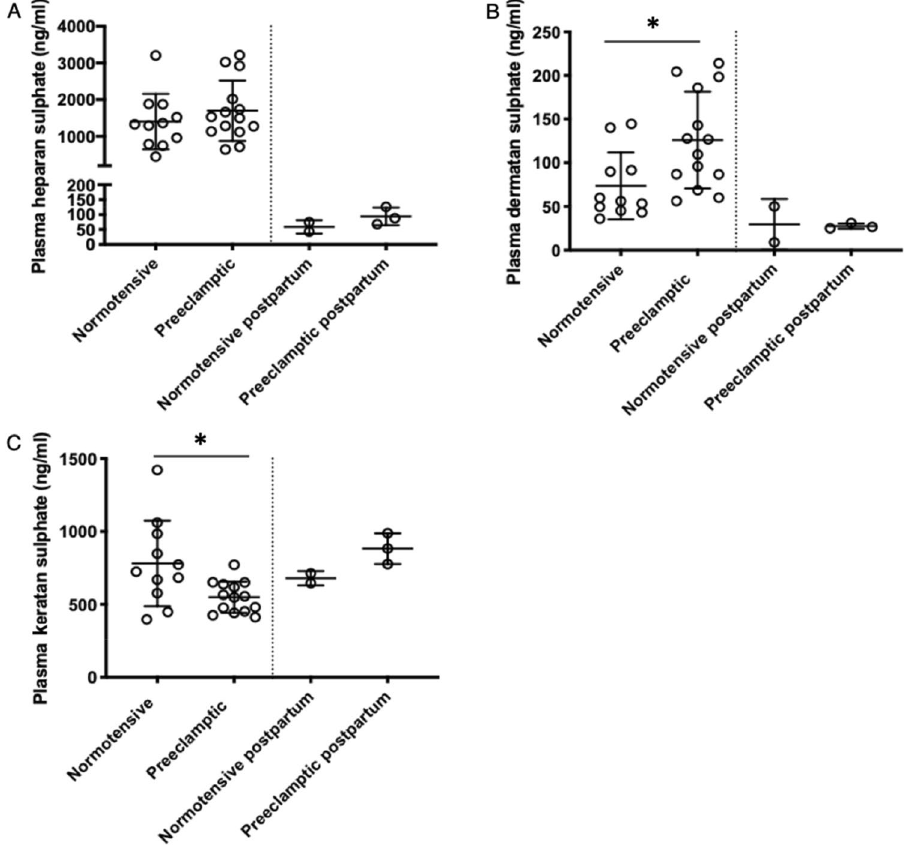
Figure 1. Plasma glycosaminoglycans during pregnancy and 3 months postpartum. Plasma glycosaminoglycans measured using HPLC–MS/MS. Bars represent mean with standard deviation. Plasma heparan sulphate in ( A ), dermatan sulphate in ( B ) and keratan sulphate in ( C ) are compared among normotensive pregnant women (NT, N = 11) and preeclamptic women (PE, N = 14) prior to delivery. Postpartum values were measured in 3 preeclamptic women and 2 normotensive women from the same population.* Indicates p <